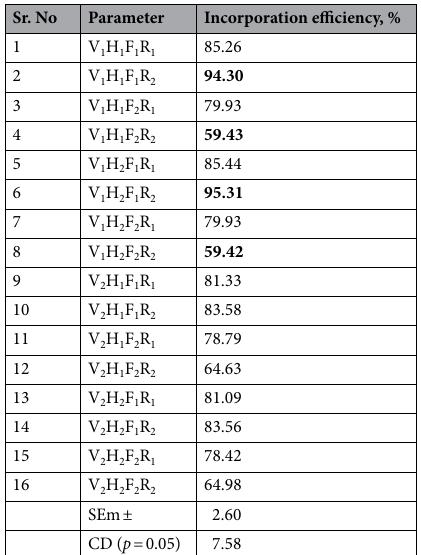
Table 10. Effect of both speed and vertical adjustment and horizontal adjustment on incorporation efficiency. (F